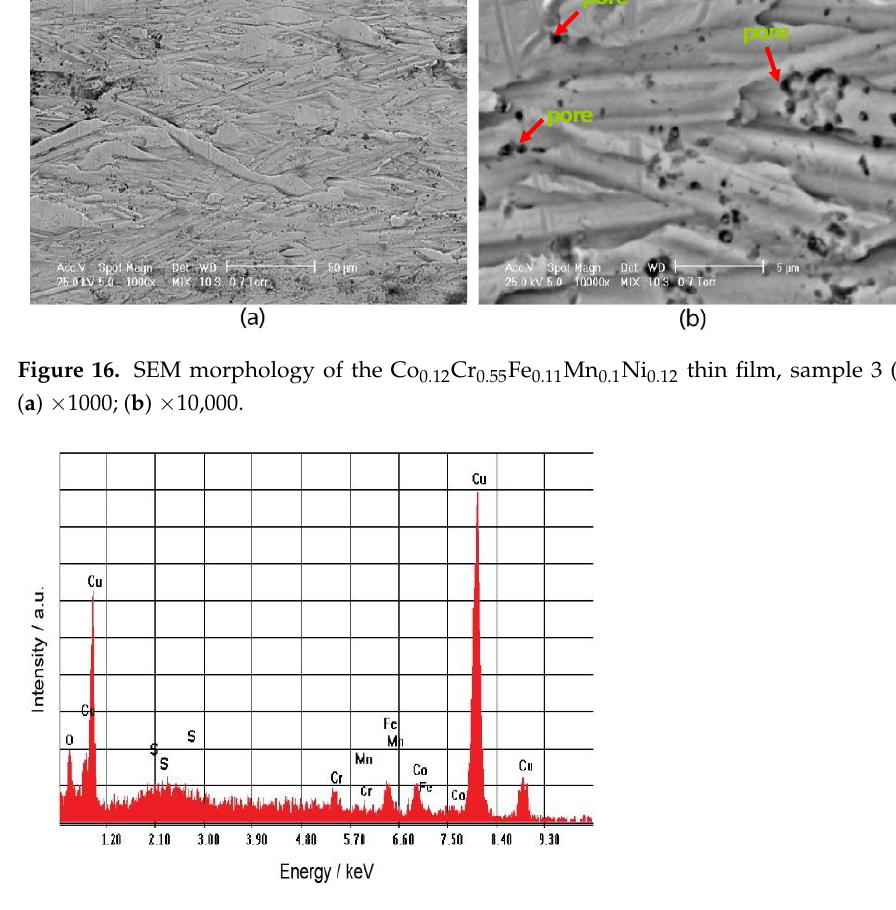
Figure 17. EDS spectra for the Co 0.12 Cr 0.55 Fe 0.11 Mn 0.1 Ni 0.12 thin film, sample 3 after corrosion. The film Co 0.12 Cr 0.55 Fe 0.11 Mn 0.1 Ni 0.12 , sample 3HT presents cracks associated to areas